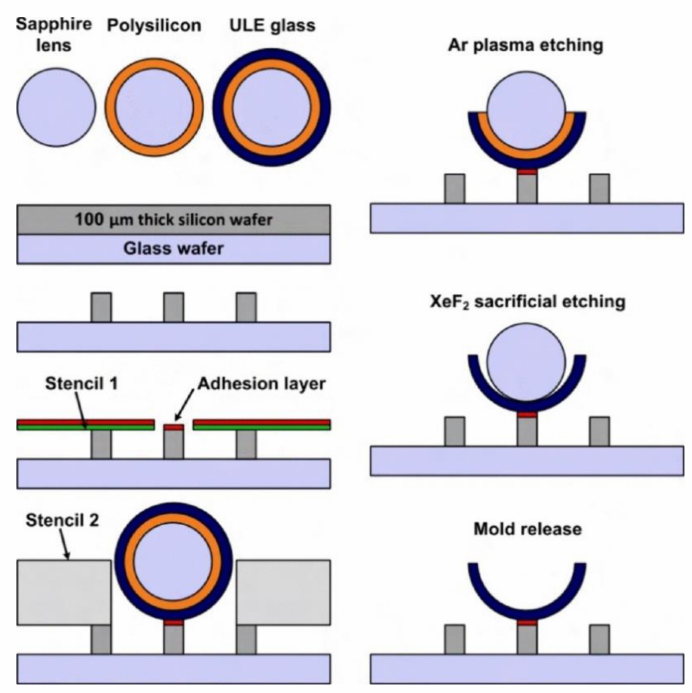
Figure 15. Detailed fabrication procedure of precision-curved micro-spherical shells (Xie et al. [54]) © 2022 IEEE. Reprinted, with permission from IEEE from Y. Xie, H. C. Hsieh, P. Pai, H. Kim, M. Tabib-Azar and C. H. Mastrangelo, “Precision-curved micro-hemispherical resonator shells